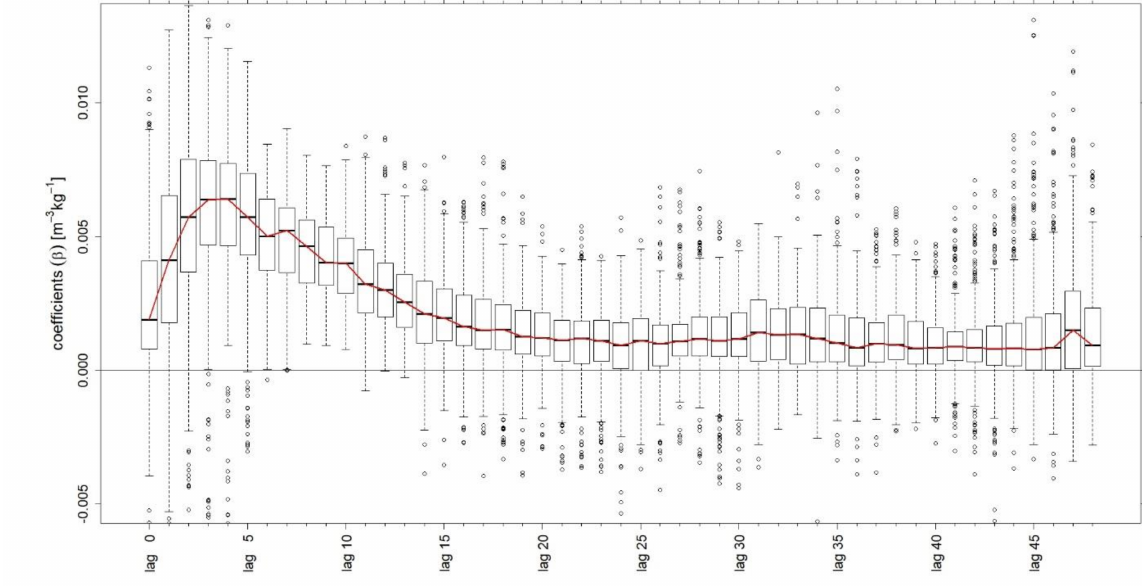
Figure 3. Boxplots of model coefficients β from the simulations of digester two with 500 training-observations and 48